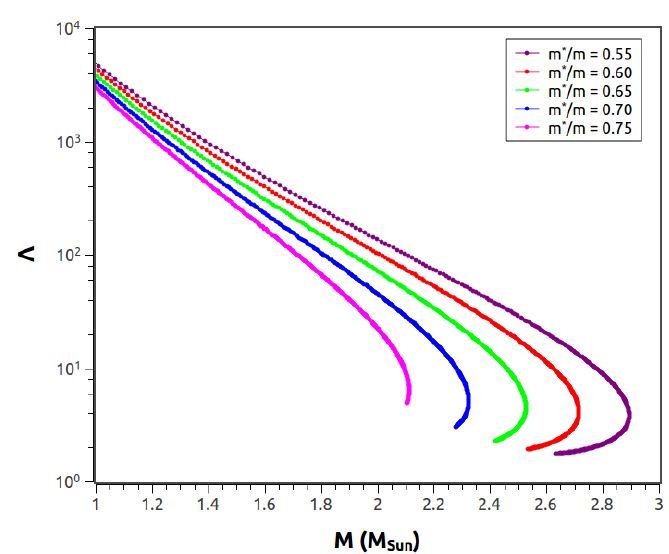
Figure 5. Dimensionless tidal deformability, Λ , as a function of neutron star mass, M , for different effective nucleon masses m ∗ / m .